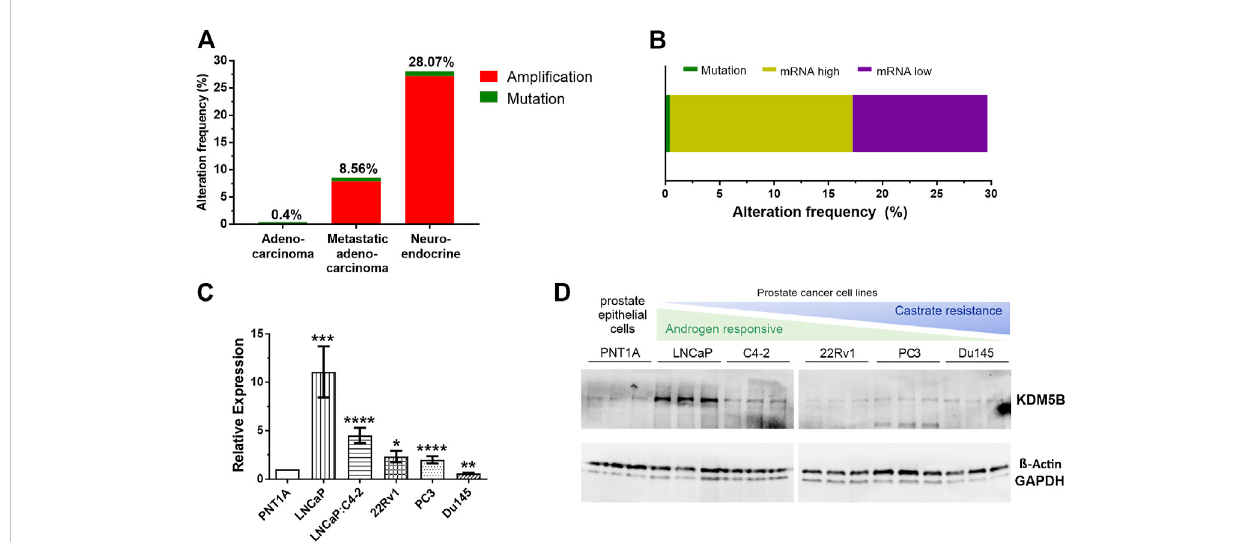
FIGURE 1 KDM5B alterationsinprostate cancer (PCa) patients. (A) Percentageof KDM5B alterations inacomparativeanalysisofprostate cancerpatients from the TCGA Provisional Prostate Adenocarcinomas, the SU2C/PCF Dream Team Metastatic Prostate Adenocarcinomas and the Trento/Cornell/Broad Neuroendocrine Prostate Cancer studies (total n = 1057). (B) Percentage mutations and KDM5B mRNA levels in the 147 TCGA PCa patients with KDM5B alterations (RNA SeqV2RSEM, mRNA expression z – score = 1). (C) KDM5B mRNA levels inPCa cell linescomparedto non-malignantepithelial cells, PNT1A.Signi fi canthigherexpressionshownforLNCaP,LNCaP:C4-2,22RV1,andARnegativePC3.DU145expressionwassigni fi cantlylowerthanPNT1A. (D) Immunoblot showing KDM5B protein levels in PCa cell lines, both Beta-Actin and GAPDH used as loading controls. Signi fi cance shown as * p ≤ 0.05, ** p ≤ 0.005, *** p ≤ 0.001, * p ≤